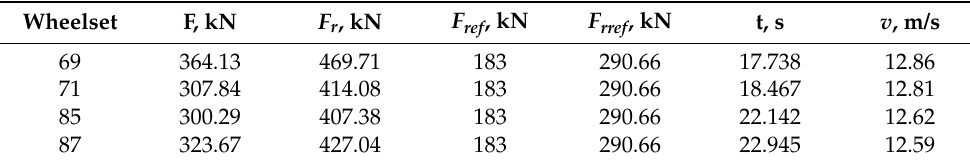
Table 2. ATLAS LG results. Maximum force, F ; reduced ATLAS LG system (hereafter referred to as reduced) maximum force, F r ; reference force, F ref ; reduced reference force, F rref ; time, t; wagon